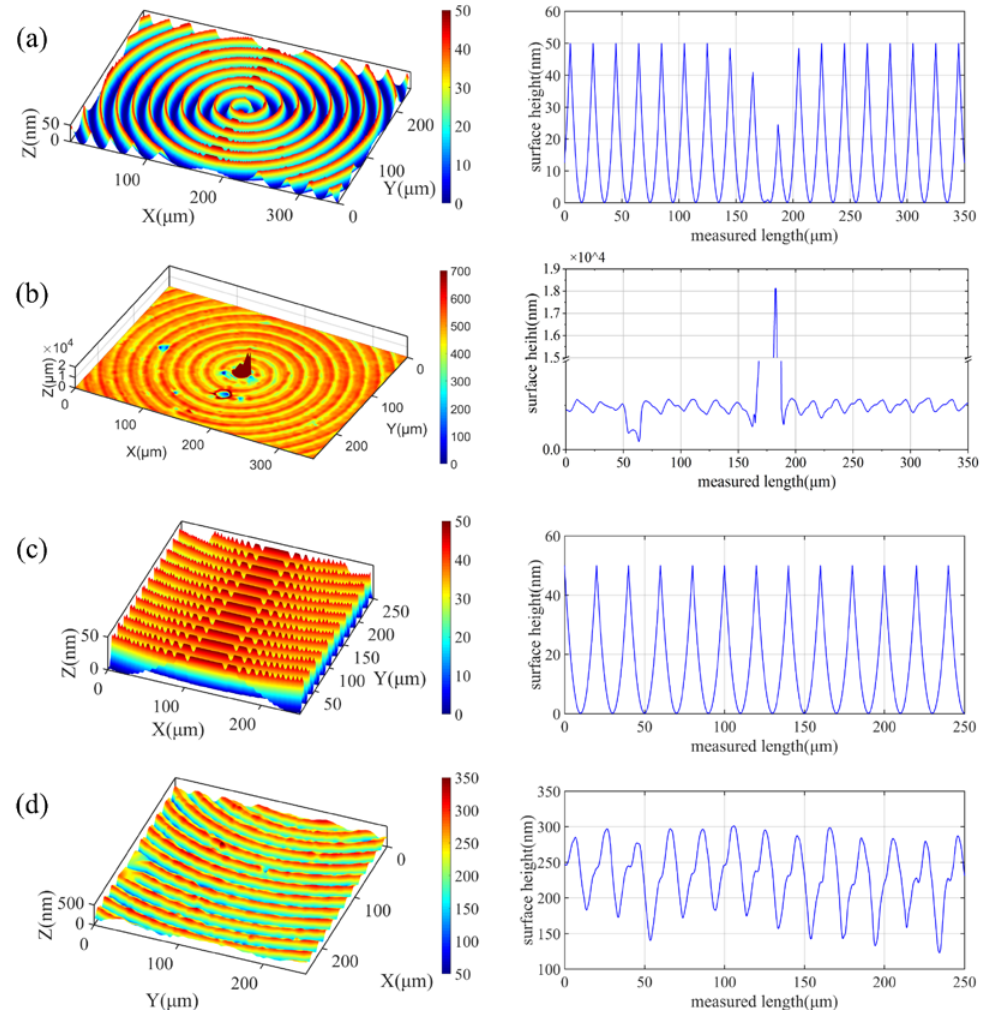
Figure 11. Comparison between the simulated and the machined surface at the center and at the radial distance of 0.3 mm: ( a ) and ( c ) are the simulated surface topography, ( b ) and ( d ) are the surface distance of 0.3 mm: ( a , c ) are the simulated surface topography, ( b , d ) are the surface topography of the topography of the machined Cu workpiece . machined Cu